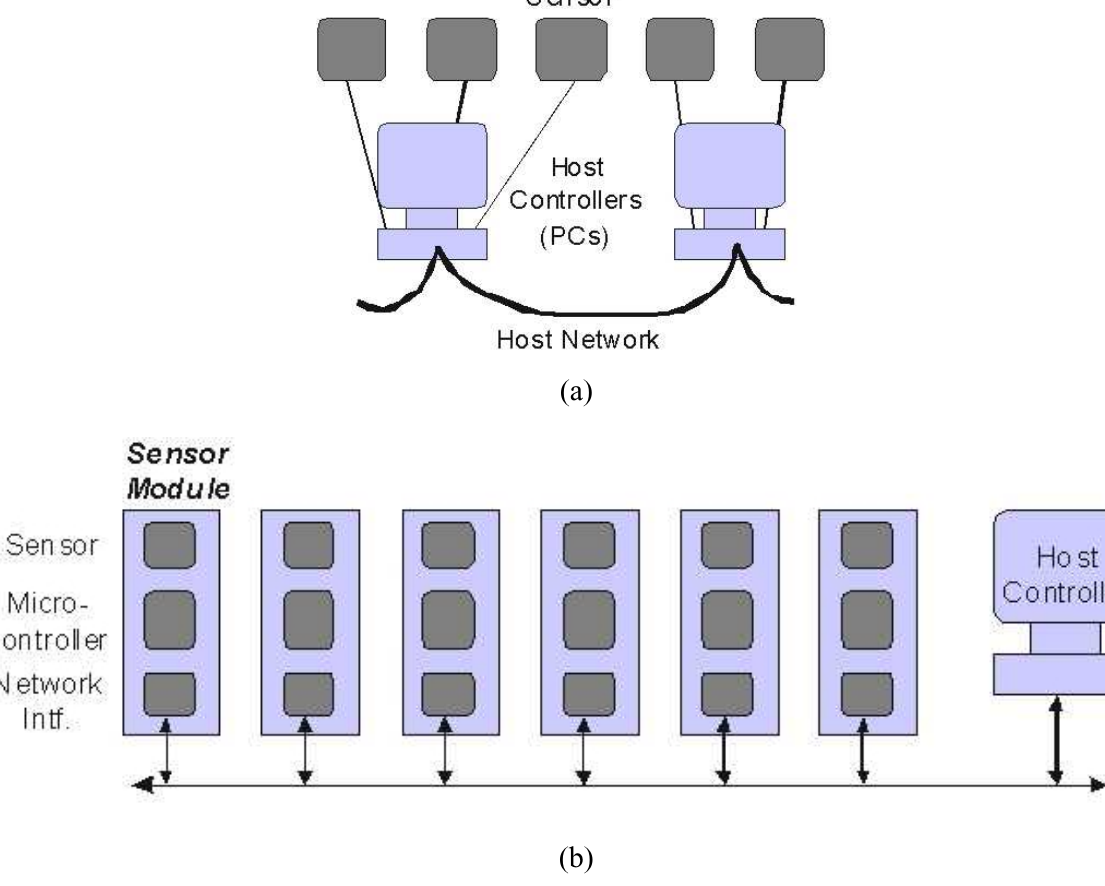
Figure 5 . Sensor networking architectures a) point-to-point connections and b) networked single-sensor